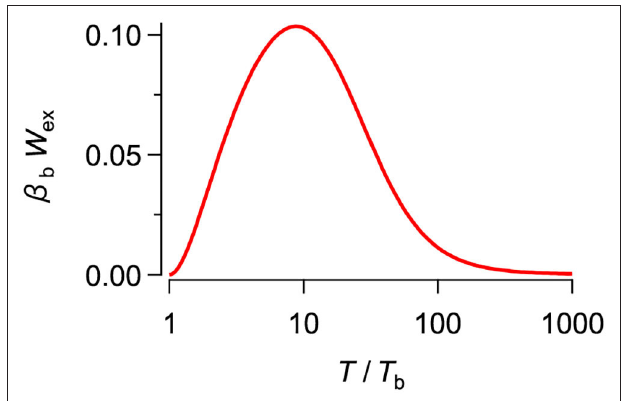
FIGURE 3 | Extractable work is a non-monotonic function of initial temperature T = β − 1 for the double-well potential of Figure 1A